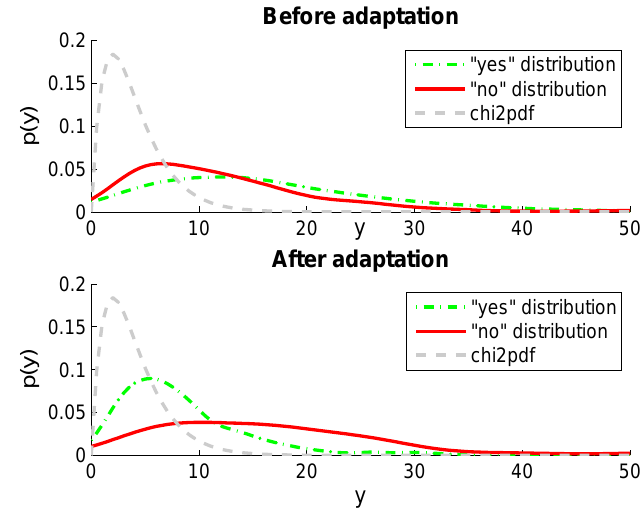
Figure 7. Class street/road probability distribution